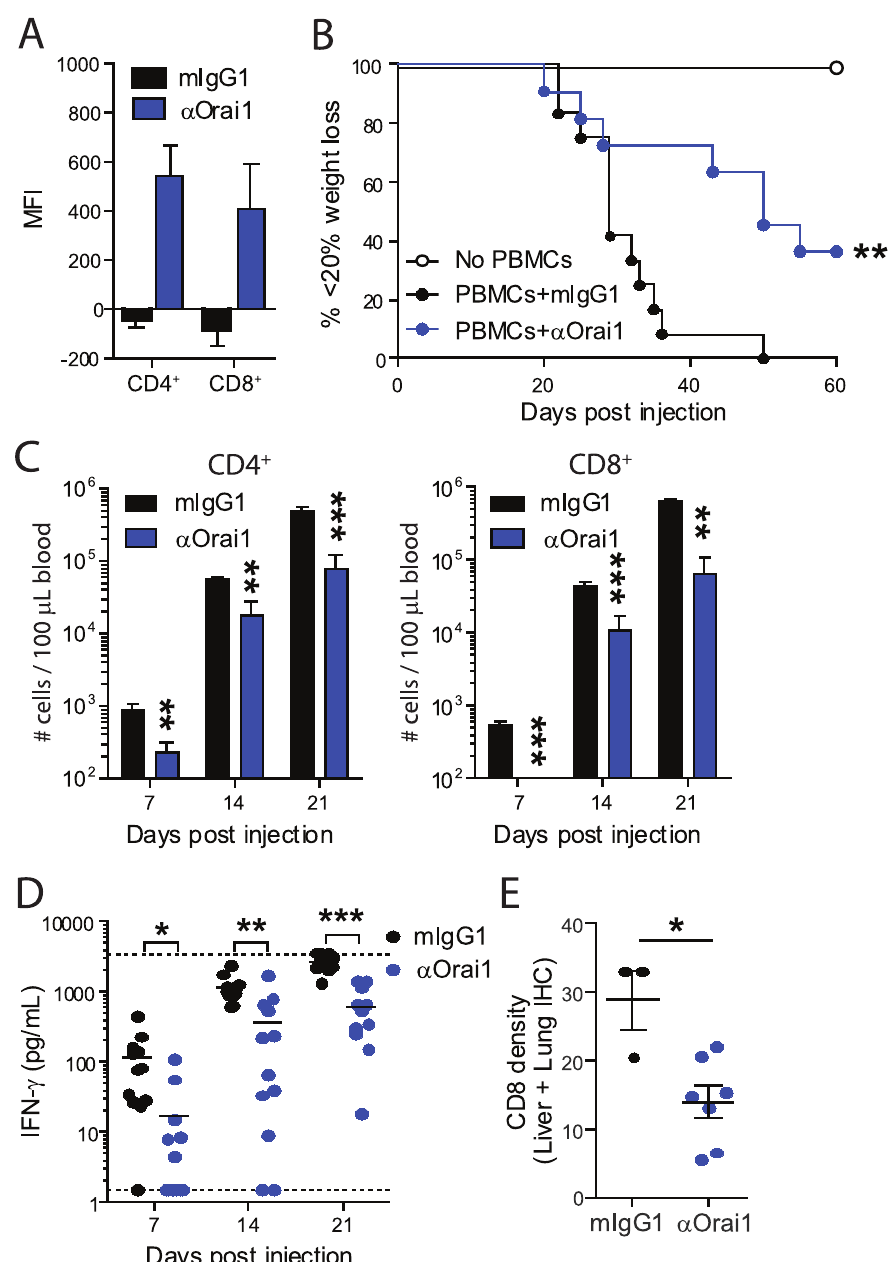
Figure 7. Anti-human Orai1 antibody attenuates xenogeneic GvHD in humanized mice. Groups of humanized NOG mice were treated with 10 mg/kg a Orai1 (N=11) or mIgG1 isotype control (N=12) 3 times per week throughout the study. Mice without PBMC transfer were included as controls (N=3). A ) Staining of Orai1 on human CD4 + and CD8 + T cells from spleens of humanized mice following the onset of GvHD. B ) Kaplan- Meier curves depict percentage of mice without GvHD defined as , 20% weight loss. C ) Absolute numbers of human CD4 + and CD8 + T cells in blood were quantified by flow cytometry on indicated days post PBMC injection. D ) Human IFN- c in plasma was measured by ELISA where horizontal dotted lines indicate assay range. E ) Paraffin-embedded sections of livers and lungs were immunohistochemically stained with anti-human CD8 and analyzed using automated image analysis software (VIS) to show the CD8 density (% tissue area stained with CD8). Data are individual or mean + / 2 SEM and representative of two separate experiments. **P , 0.01 by Mantel-Cox Log-Rank test compared to PBMCs + mIgG1 (B). *p , 0.05, **P , 0.01, ***P , 0.001 by Mann-Whitney U-test (B-D). In (D), samples above range were given the maximum assay value and included in statistics whereas values below detection were plotted with the value 1, but not included in